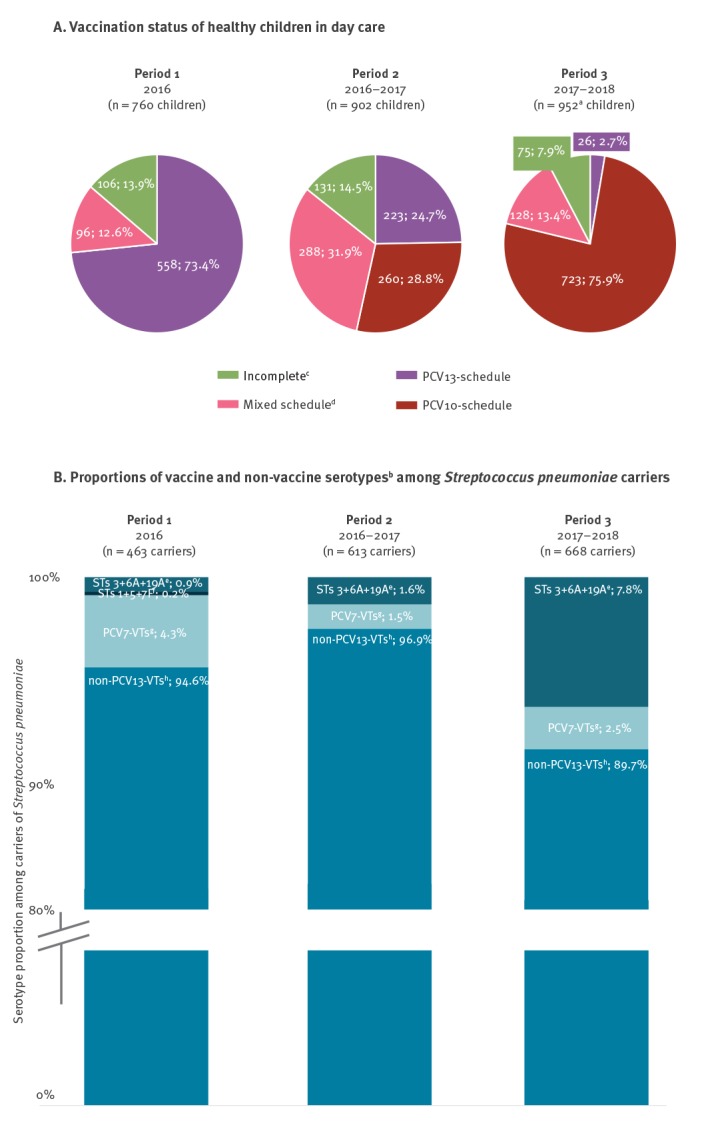
(A) Vaccination status of healthy children in day care (n = 760 in 2016, 902 in 2016–2017, 952a in 2017–2018) and (B) proportions of vaccine and non-vaccine serotypesb among Streptococcus pneumoniae carriers (n = 463 carriers in 2016, 613 in 2016–2017, 668 in 2017–2018), Belgium, 2016–2018